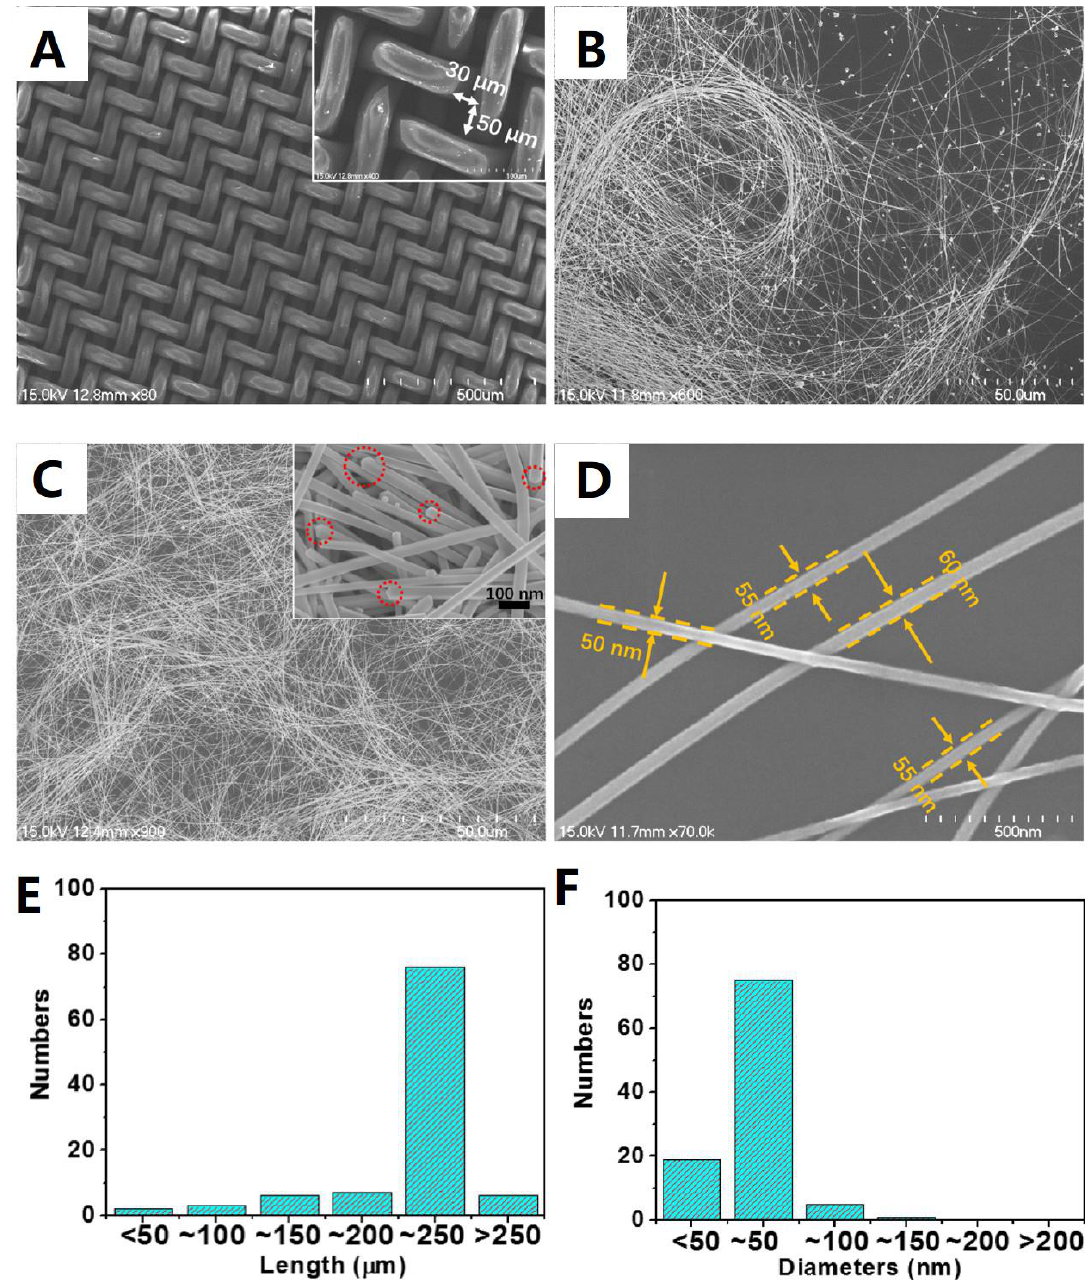
Figure 6. ( A ) Filter cloth used to remove short-length nanowires (NWs) and nanoparticles (NPs), SEM images of AgNWs before ( B ) and after ( C ) filtration with inset showing the penta-twinned structure ( D ) SEM image of AgNWs, the distribution of ( E ) length, and ( F ) diameters [63].